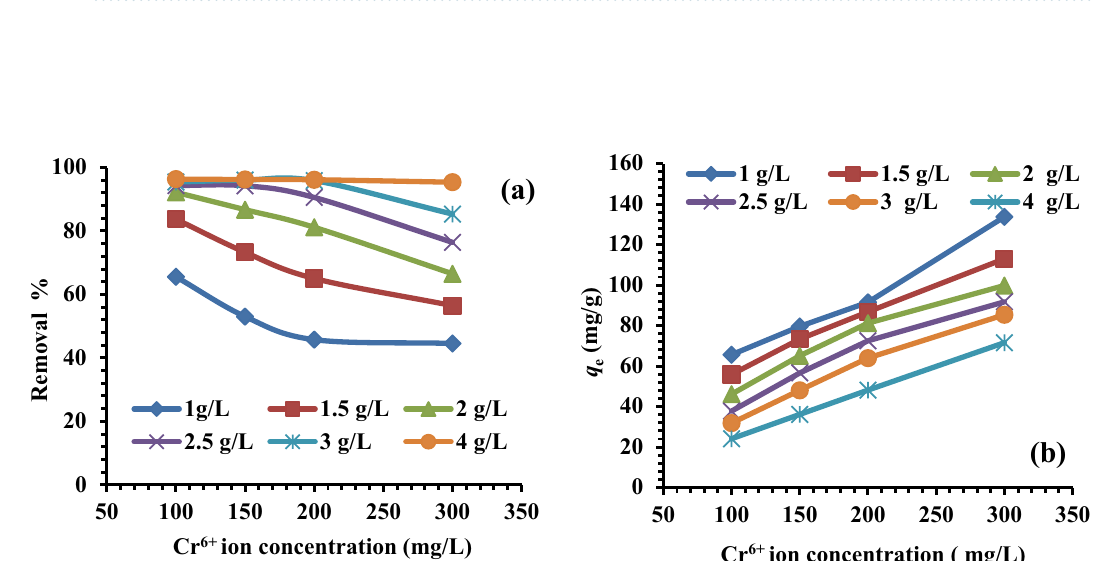
Figure 9. ( a ) Impact of starting Cr 6+ ions concentration onto the removal process, ( b ) Relationship between Cr 6+ ions absorbed quantities at equilibrium ( q e ) and its beginning concentration by various MG-OPAC